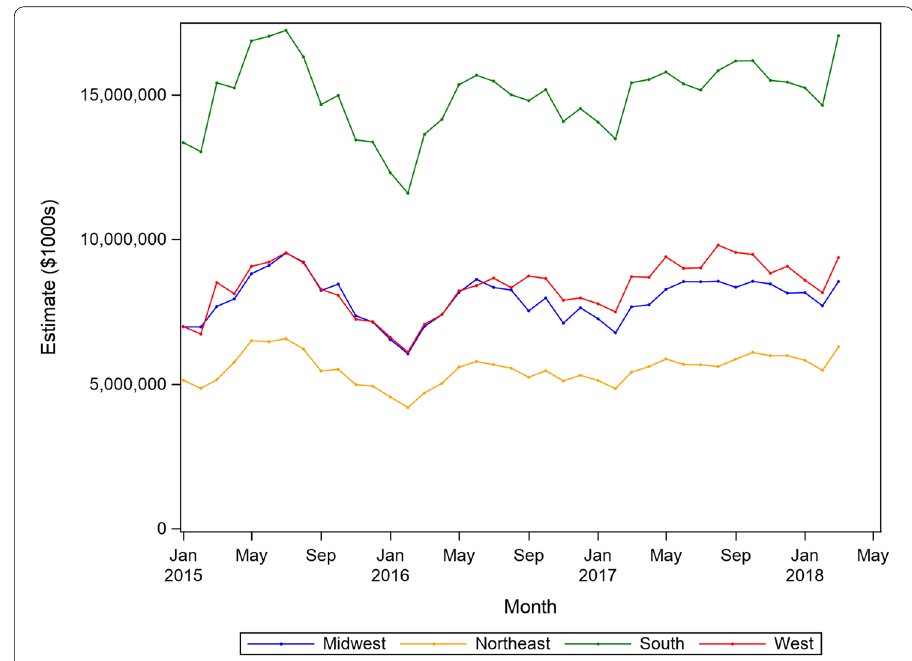
Fig. 8 Regional estimates of retail sales over time for NAICS 447 (gasoline stations)